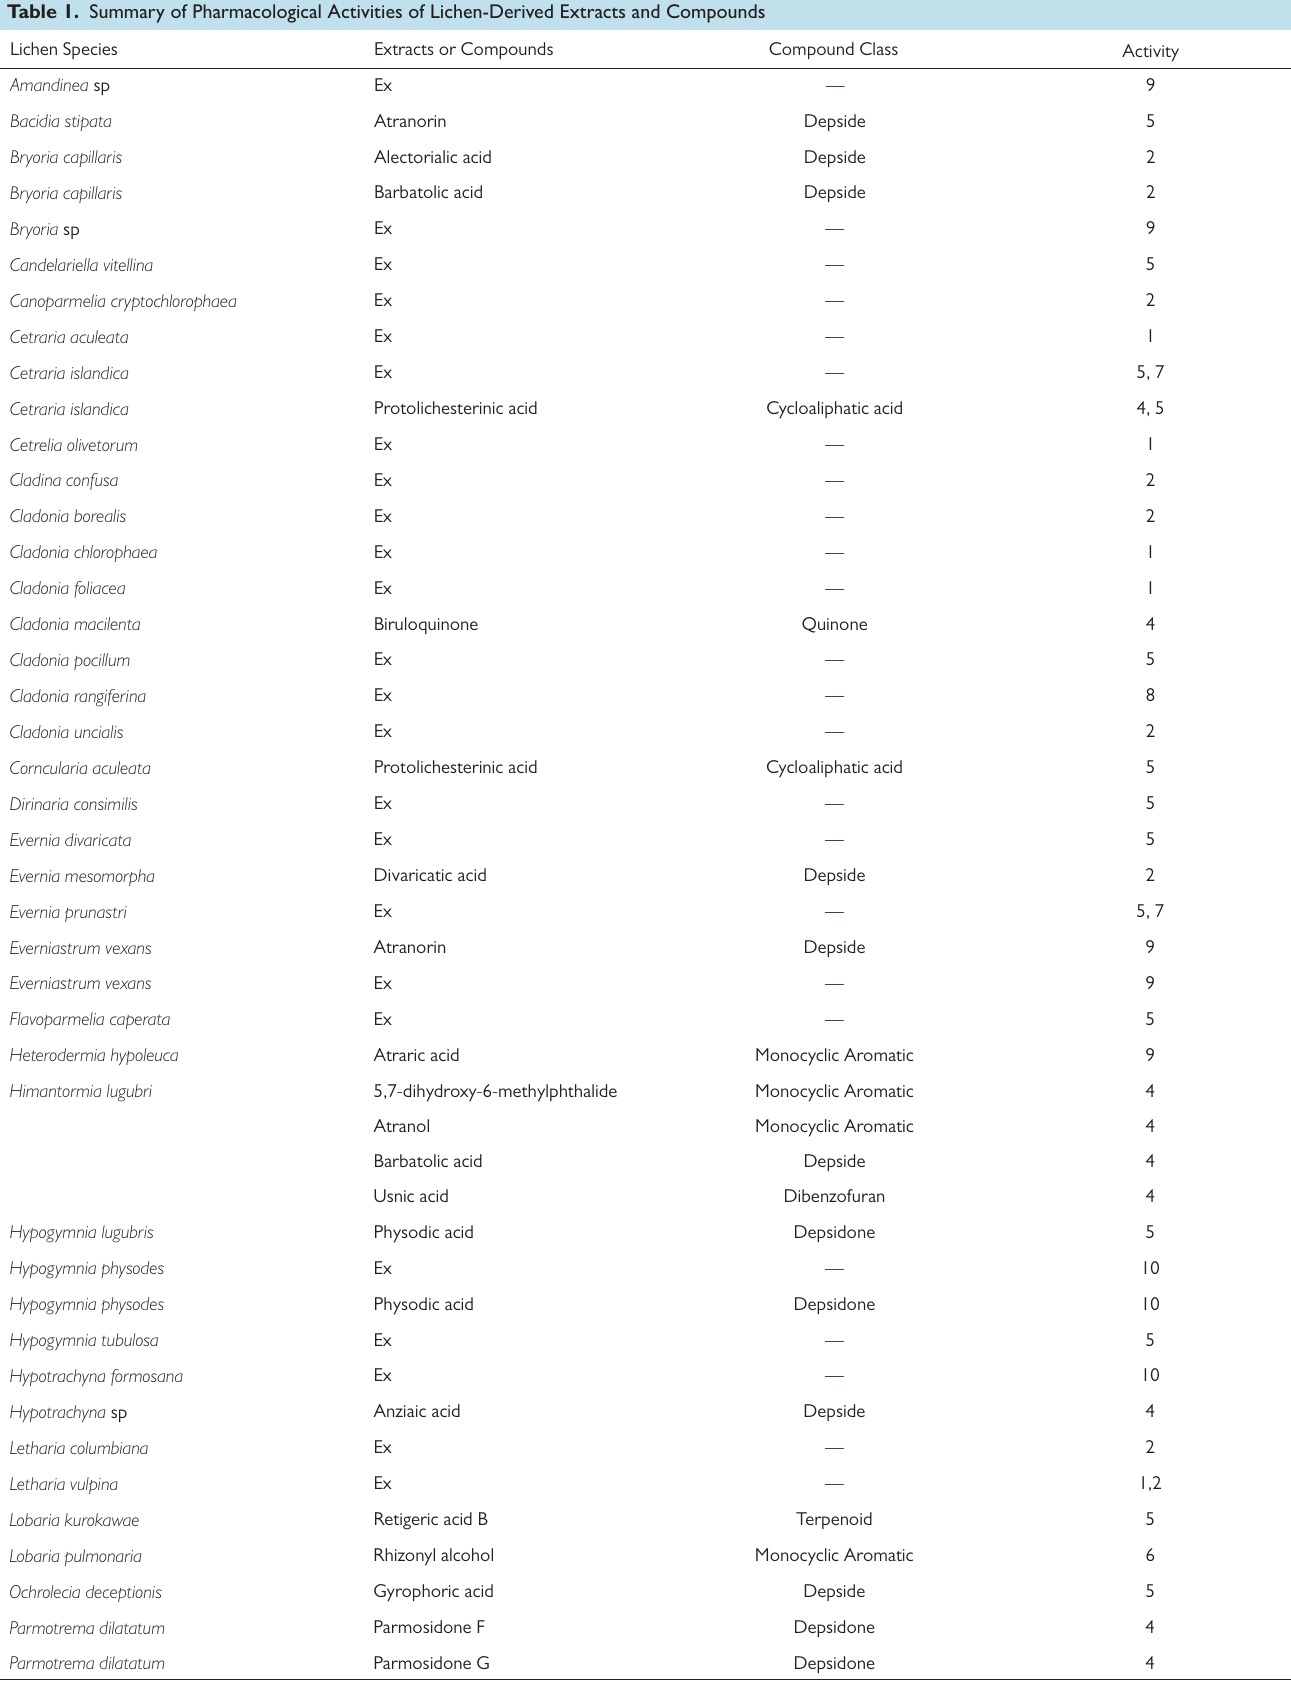
Table 1. Summary of Pharmacological Activities of Lichen-Derived Extracts and Compounds Lichen Species Extracts or